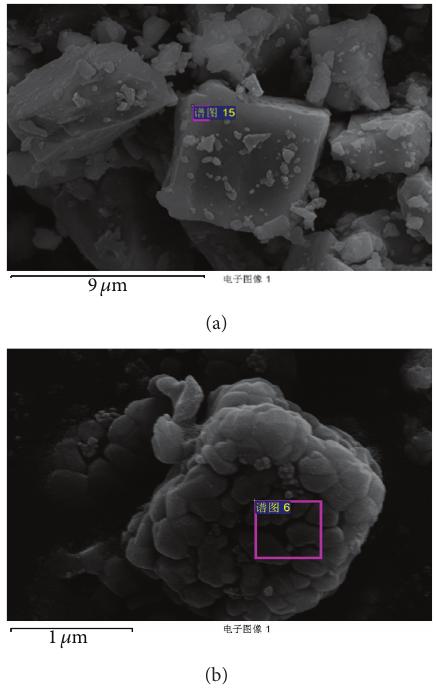
Figure 5: SEM images of naked barite (a) and B/TCP (b).